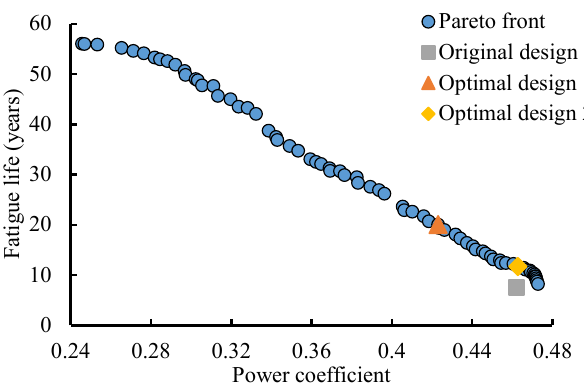
Figure 11. Pareto front of the multi-objective optimization.